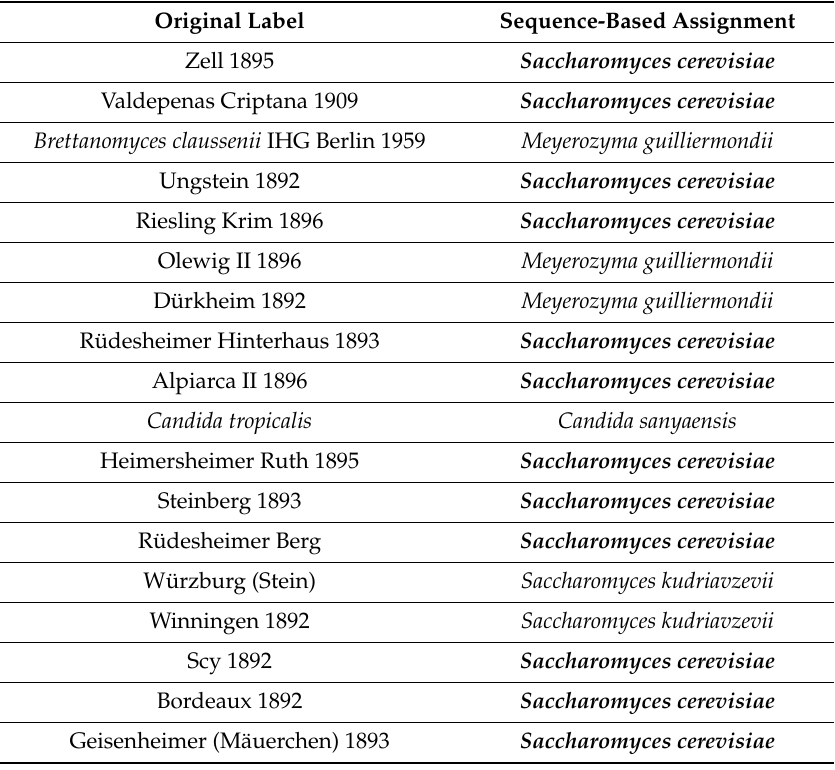
Table 1. Strains used in this